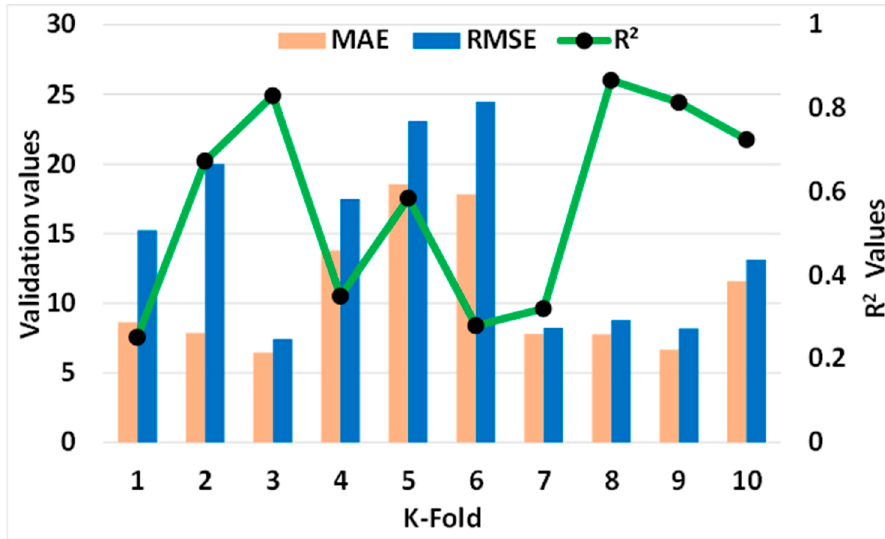
Materials 2022 , 15 , x FOR PEER REVIEW Figure 18. Statistical analysis of MLP model. Figure 18. Statistical analysis of MLP model.